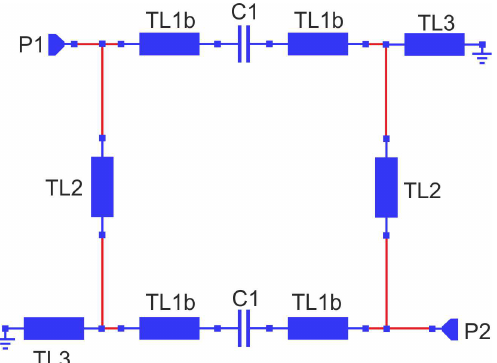
Figure 8. Capacitively loaded transmission line implementation of the lumped prototype filter shown in Figure